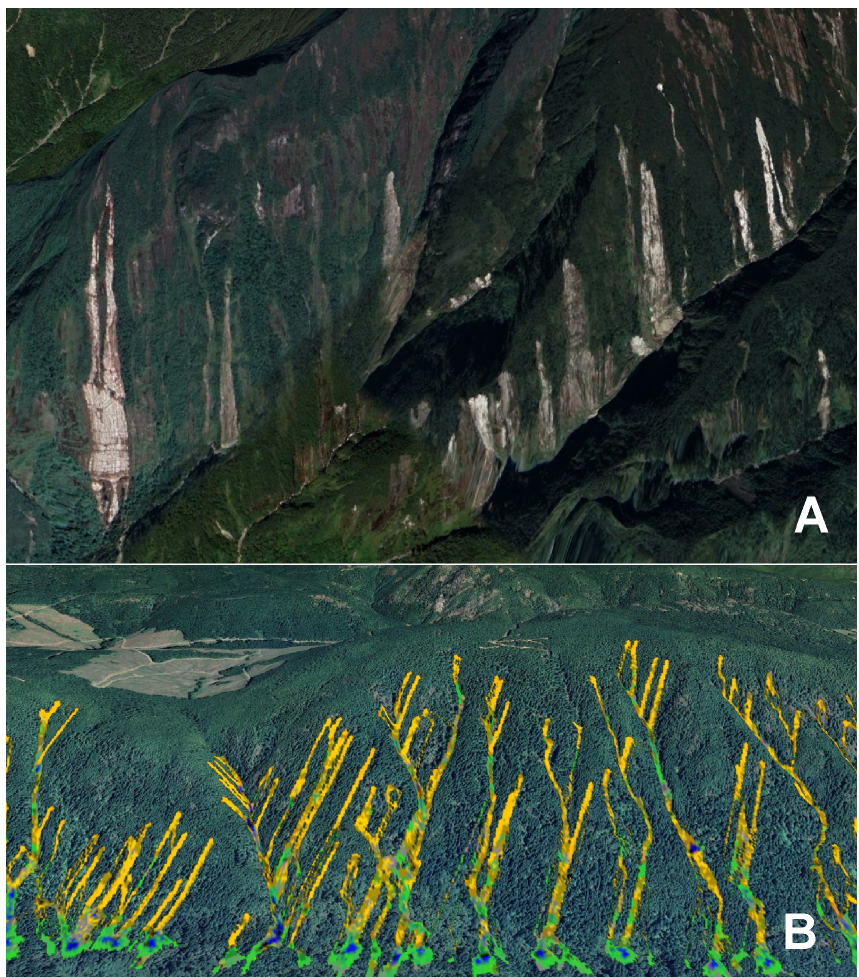
Figure 23. Strong linear orientation of landslide tracks on steep slopes in Indonesia (a) where multiple landslides occur at once and on the north shore of Cowichan Lake (b) where multiple landslides were modeled to occur at once (background images © Google Earth).